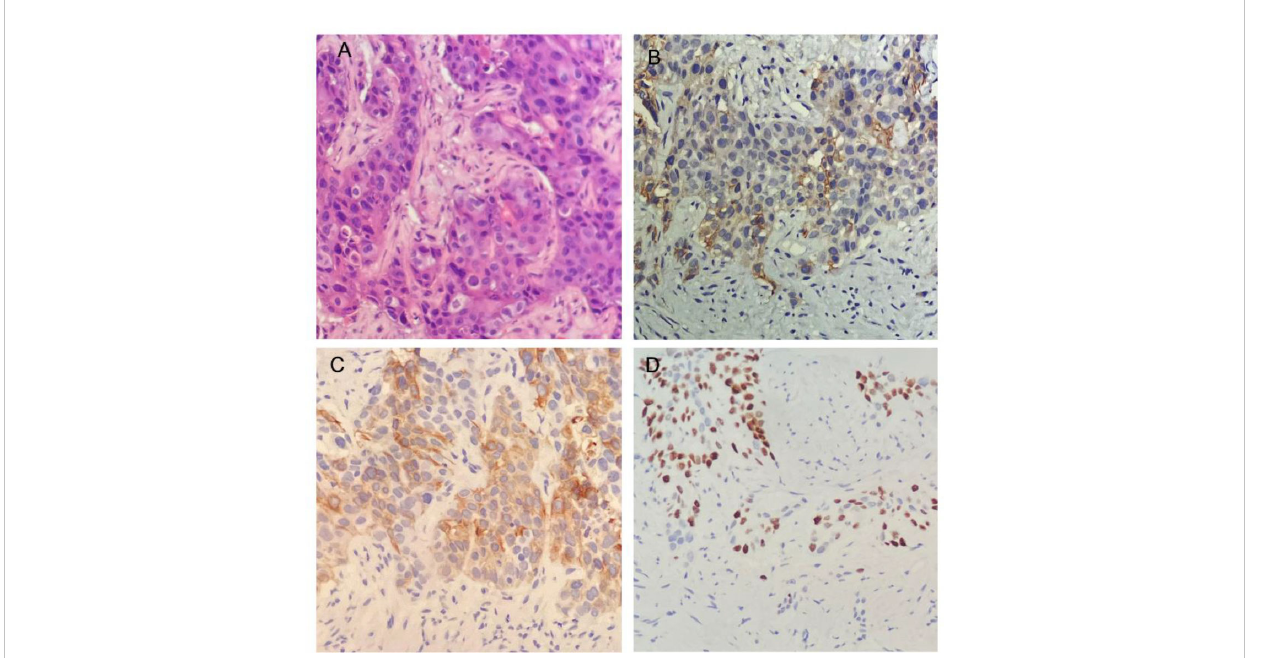
FIGURE 1 Histopathology and immunohistochemistry (IHC) of the biopsies from liver metastases. (A) Histological fi ndings revealed squamous cell carcinoma (HE × 200). (B) IHC staining for the expression of programmed cell death – ligand 1 (×200). (C, D) IHC staining yielded positive results for CK20 (C) and P40 (D) (×200).